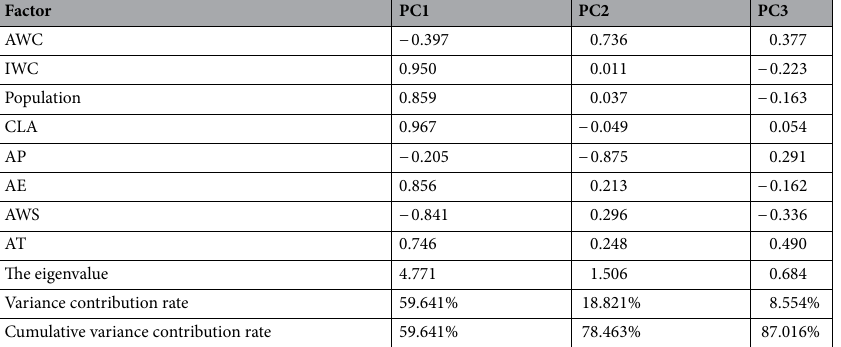
AWS − 0.841 0.296 − 0.336